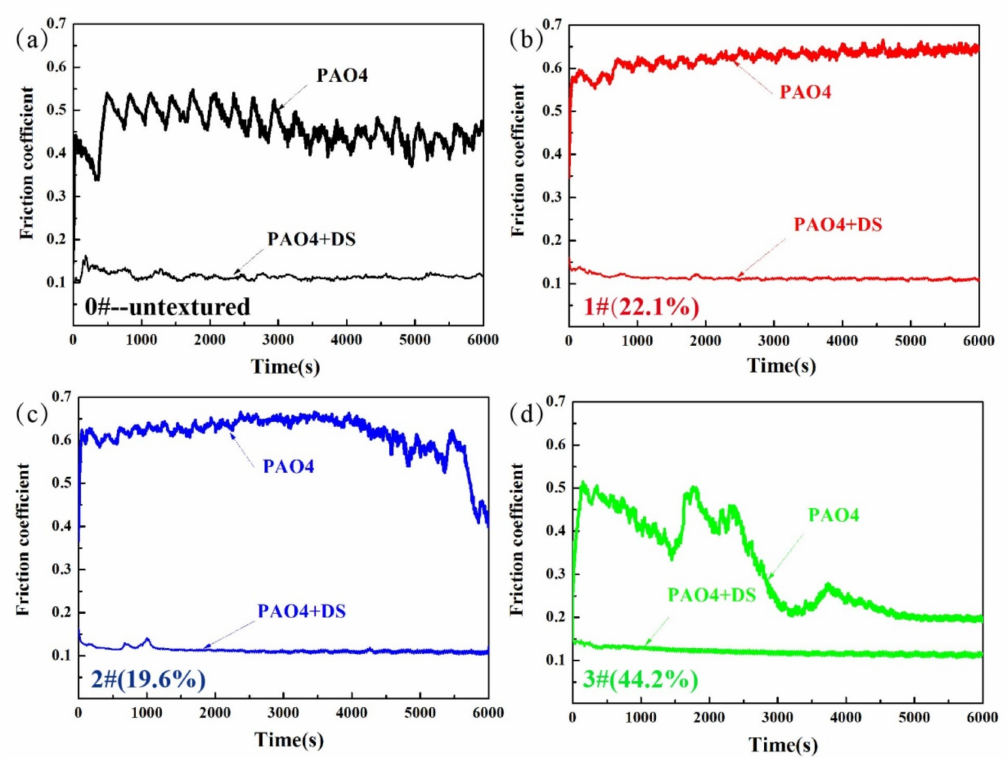
Figure 6. Friction coefficient curves of different samples ( T = 100 ◦ C): ( a ) 0#; ( b ) 1#; ( c ) 2#; ( d ) 3#.